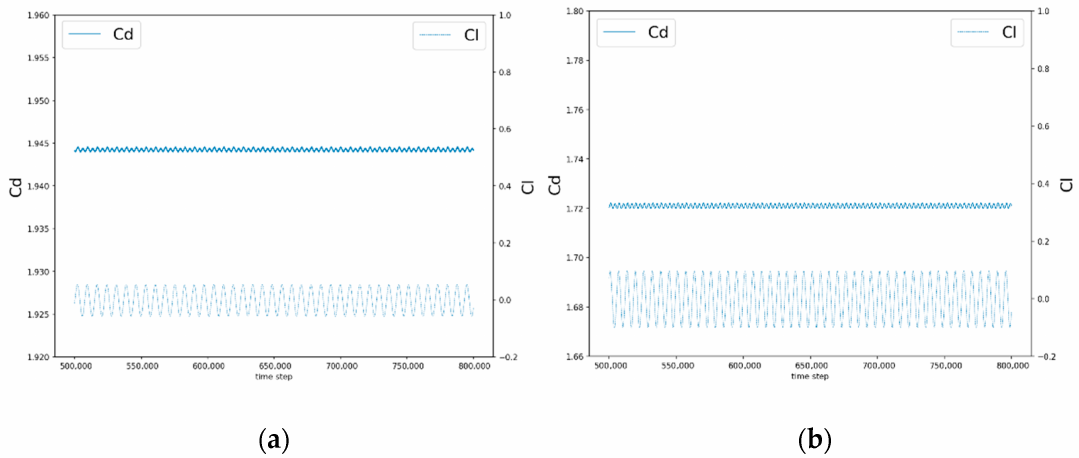
Figure 17. Elliptical cylindrical bypass: lift and drag coefficients (Cl and Cd) when ( a ) Re = 100 and ( b ) Re = 150.